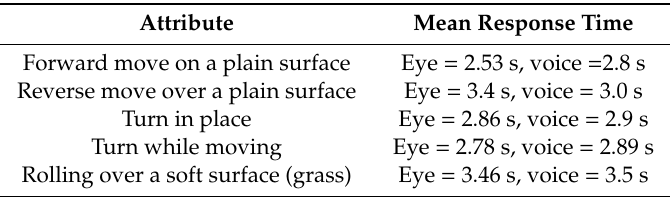
Table 2. System response for WST.